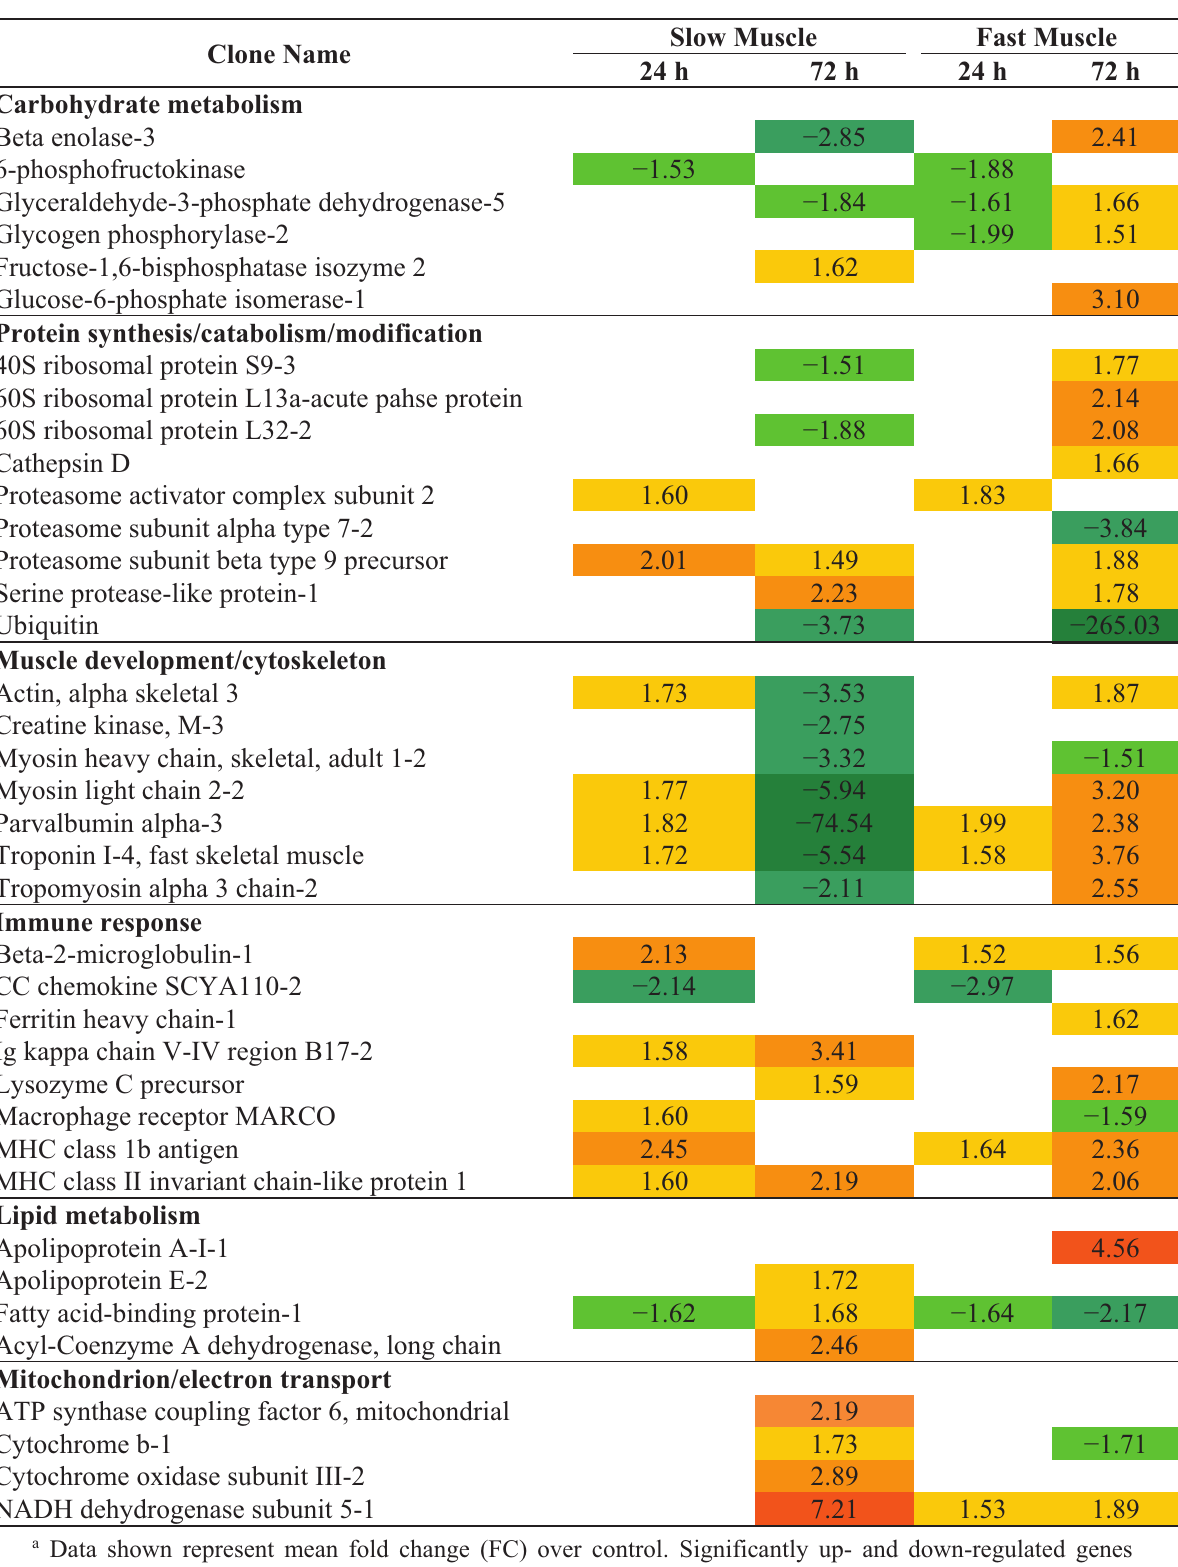
Table 2. Differentially expressed genes representative of various physiological processes in slow and fast skeletal muscle at 24 and 72 h after lipopolysaccharide administration in rainbow trout a